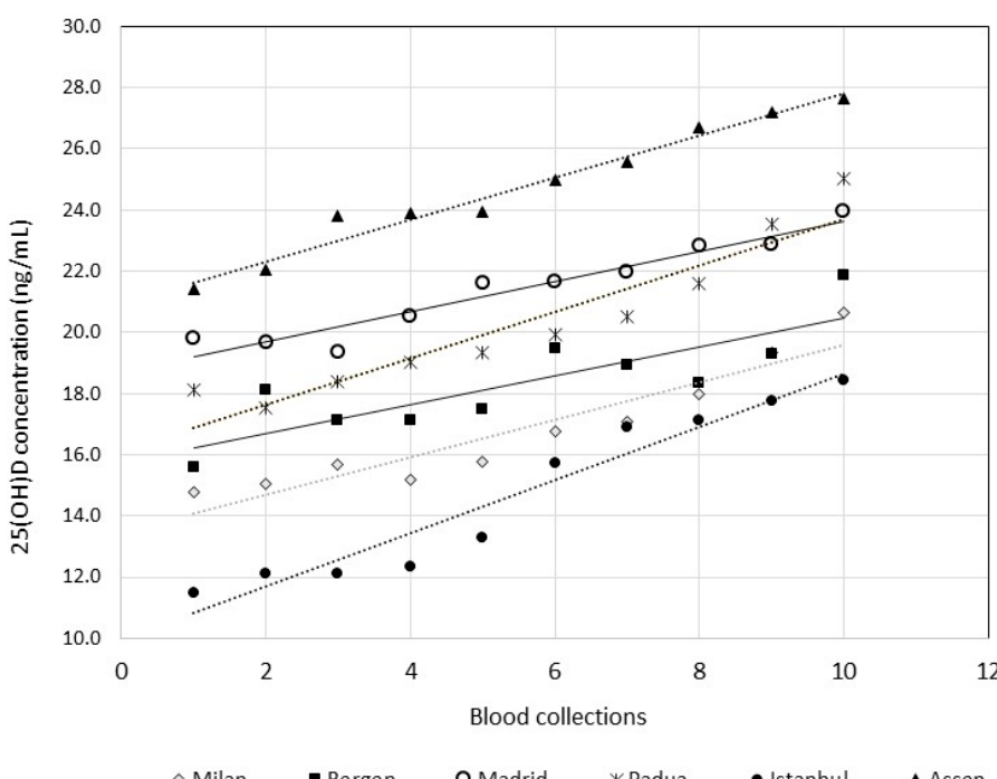
Figure 2. An x/y plot for vitamin D mean values (Y) versus blood collections (X), according to the countries. Linear regres- sion equation and Pearson correlation coefficient ( r ) produced the following: Milan, Italy: Y (ng/mL) = 0.61 × (0.44 − 0.79) + 13.5 (12.4 − 14.5), r = 0.943; Bergen, Norway: Y (ng/mL) = 0.47 × (0.22 − 0.72) + 15.7 (14.2 − 17.3), r = 0.840; Madrid, Spain: Y (ng/mL) = 0.50 × (0.38 − 0.61) + 18.7 (18.0 − 19.4), r = 0.964; Padua, Italy: Y (ng/mL) = 0.76 × (0.54 − 0.98) + 16.1 (14.8 − 17.5), r = 0.944; Istanbul, Turkey: Y (ng/mL) = 0.87 × (0.68 − 1.06) + 9.9 (8.8 − 11.1), r = 0.967; Assen, The Netherland: Y (ng/mL) = 0.68 × (0.59 − 0.78) + 21.0 (20.4 − 21.5), r = 0.986.